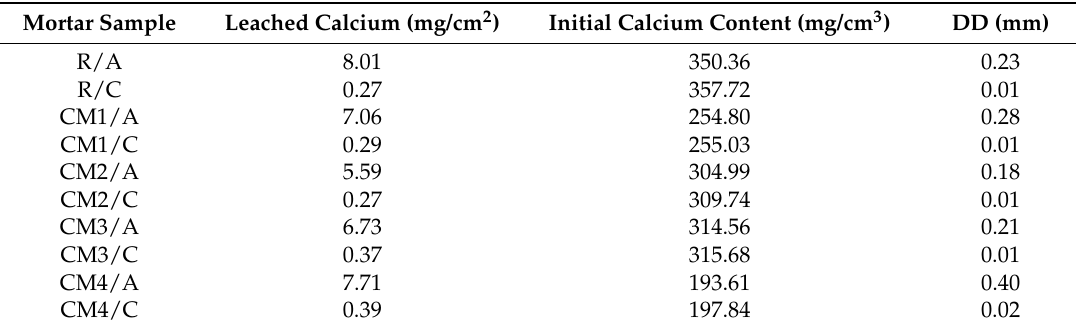
Table 3. Damaged depths of mortars over the 180-day